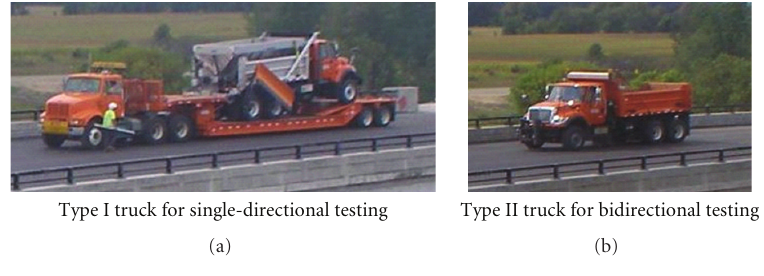
Figure 5: General configurations of trucks. Table 3: Measured surface deflections.